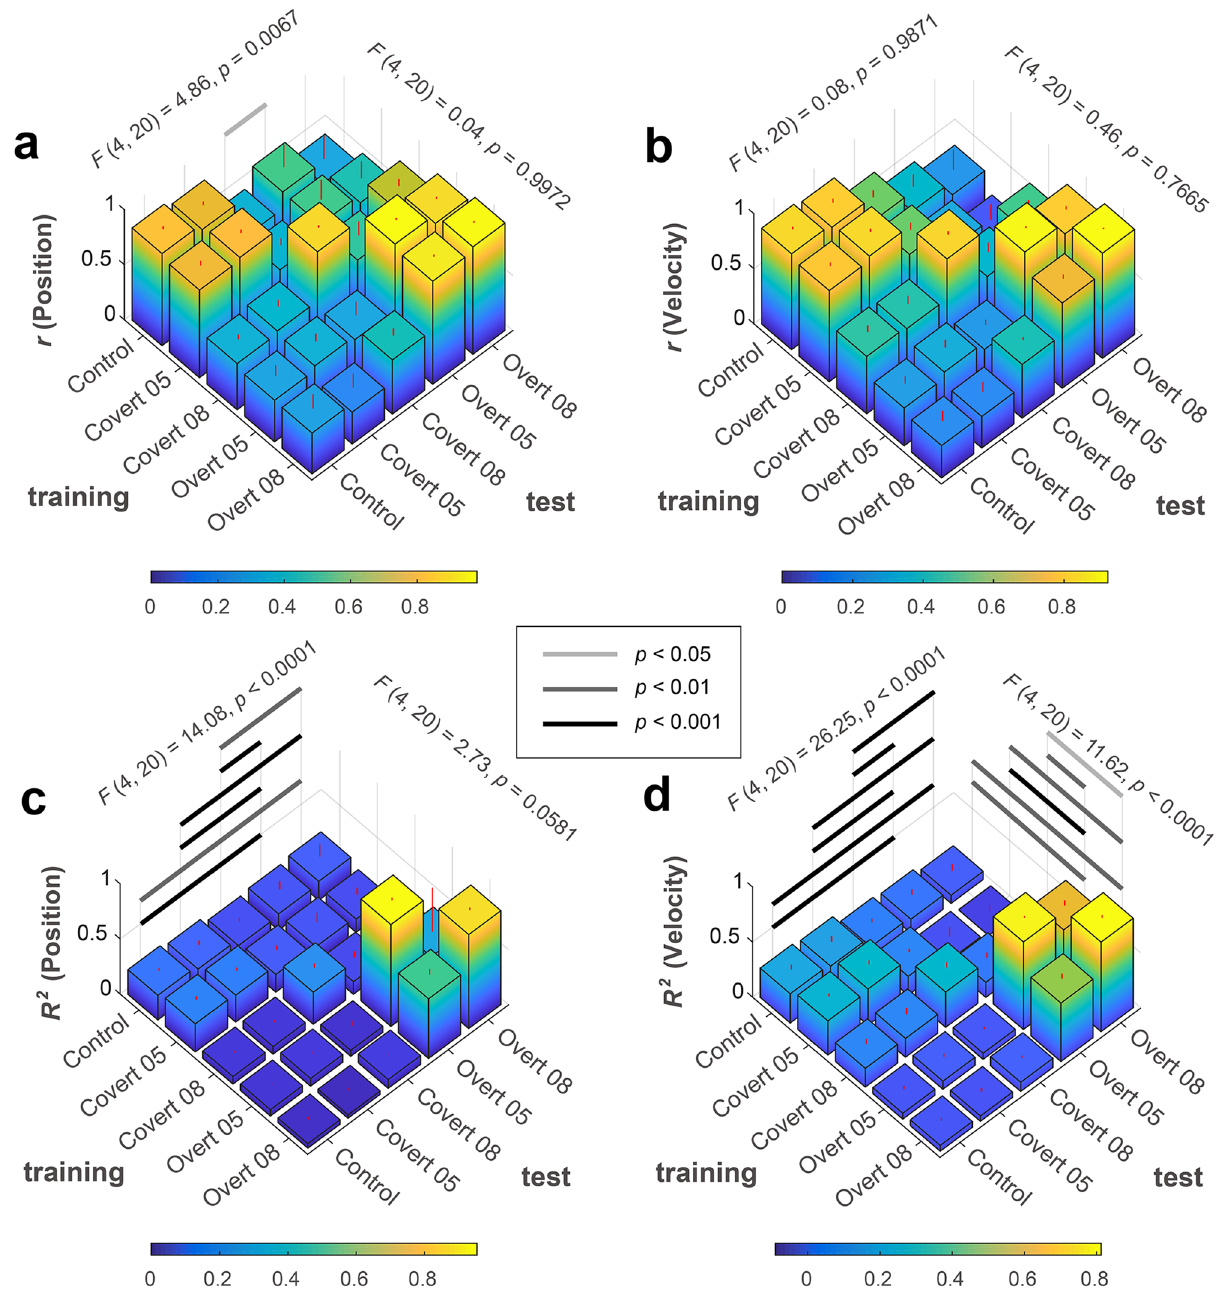
Figure 4. Randomized block design two-way ANOVA with Tukey’s multiple comparison test results of coefficients among task types for training and test datasets. ( a ) Correlation coefficients between target and reconstructed positions. ( b ) Correlation coefficients between target and reconstructed velocities. ( c ) Determination coefficients between target and reconstructed positions. ( d ) Determination coefficients between target and reconstructed